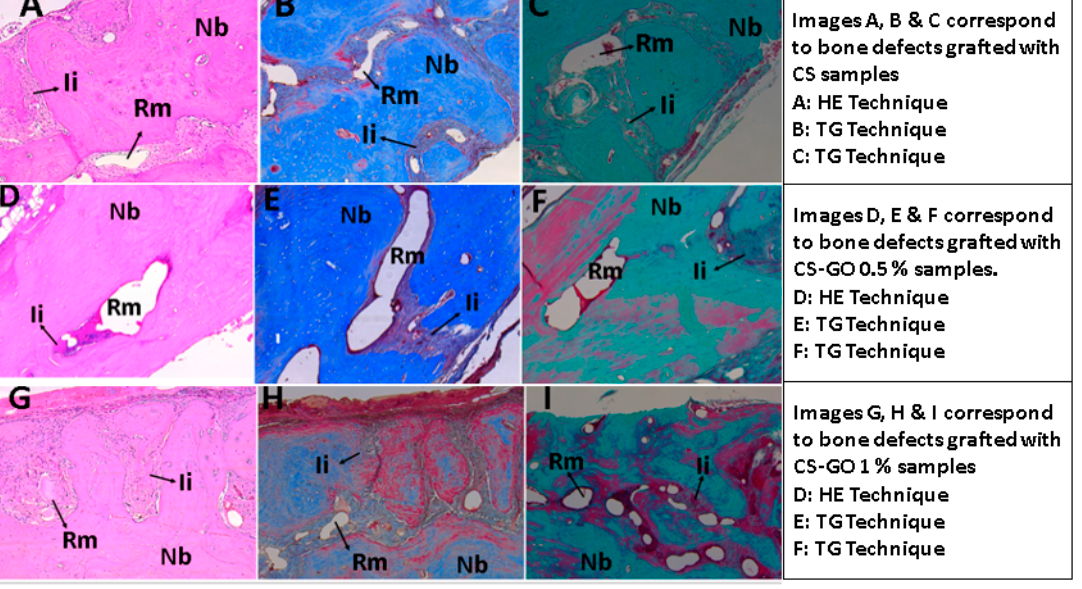
Figure 3. Experimental samples with images at 10×. Nb: Newly formed bone, Rm: Remnant material, Ii: Inflammatory infiltrate.